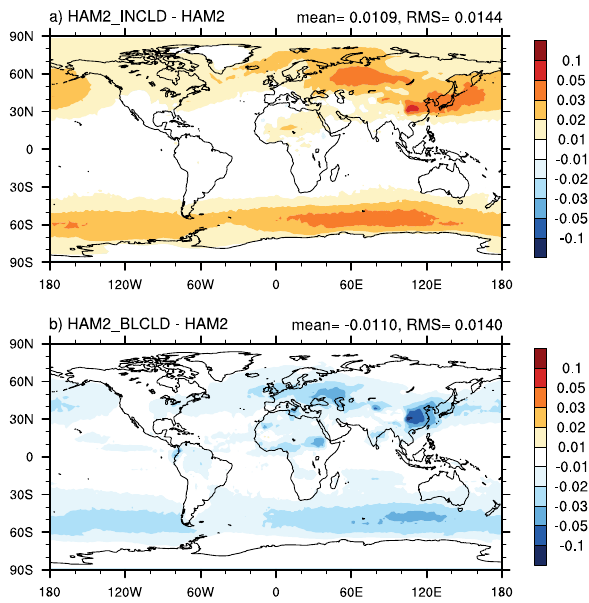
Fig. 7. Changes in annual mean AOD caused by (a) modification in the in-cloud scavenging of mixed-phase stratiform clouds; (b) mod- ifications in the below-cloud (rain and snow) scavenging parameter- ization (Croft et al., 2009); the global mean and root mean square differences are noted above each panel. The standard configuration of HAM2 has a global and annual mean AOD of 0.135. The three experiments (HAM2, HAM2 INCLD and HAM2 BLCLD, cf. Ta- ble 4) are identical in all other aspects of model configuration. Fur- ther details can be found in Sects. 4.2.1 and